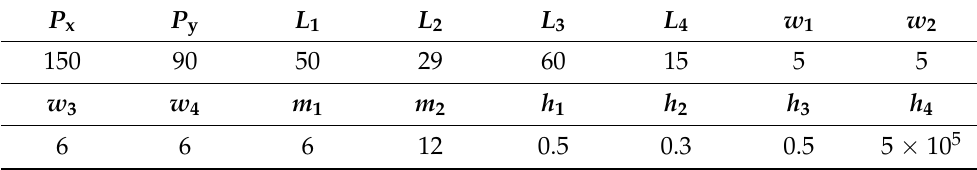
Table 1. Parameter configuration of the proposed THz hybrid metasurface ( µ